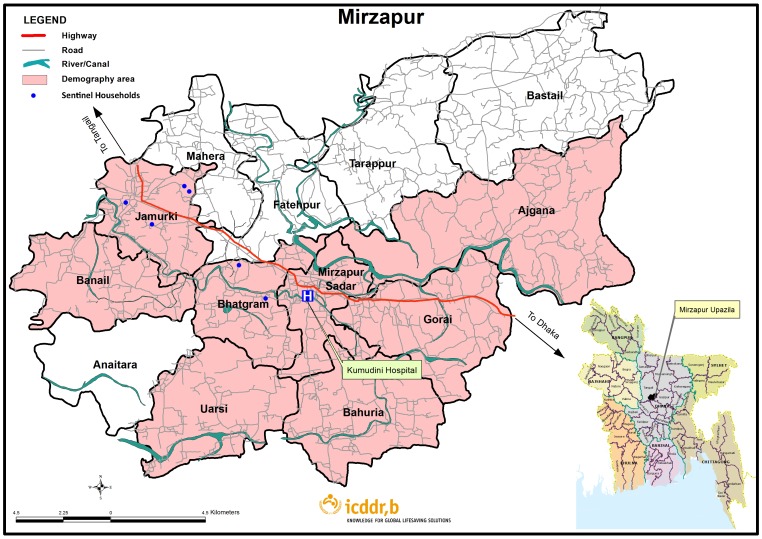
Map of the Mirzapur DSS showing Kumudini hospital and the 6 randomly-chosen sentinel households.